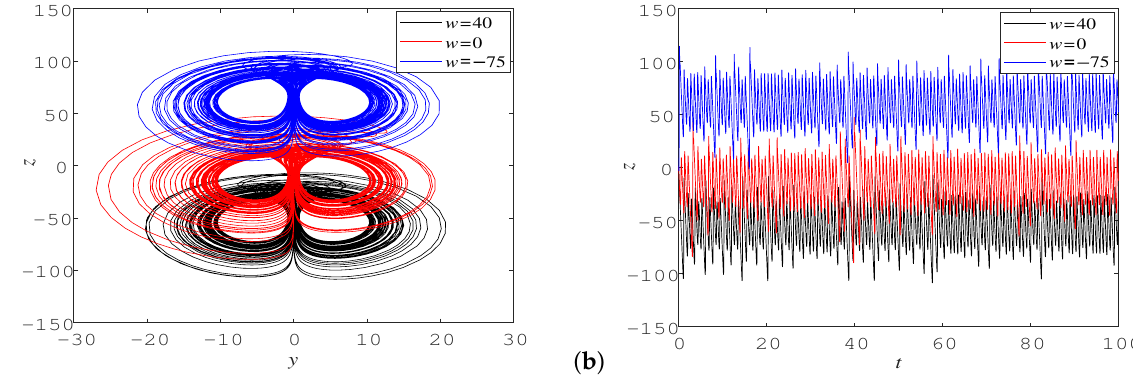
Figure 19. ( a ) Chaotic attractors with different offsets w in the y - z plane; ( b ) State z with different values of the offset boosting controller w